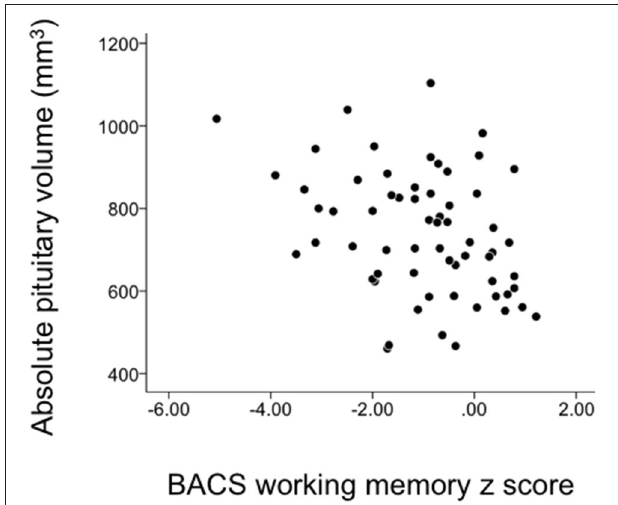
FIGURE 3 | Correlation between the pituitary volume and the Brief Assessment of Cognition in Schizophrenia (BACS) working memory score in schizophrenia